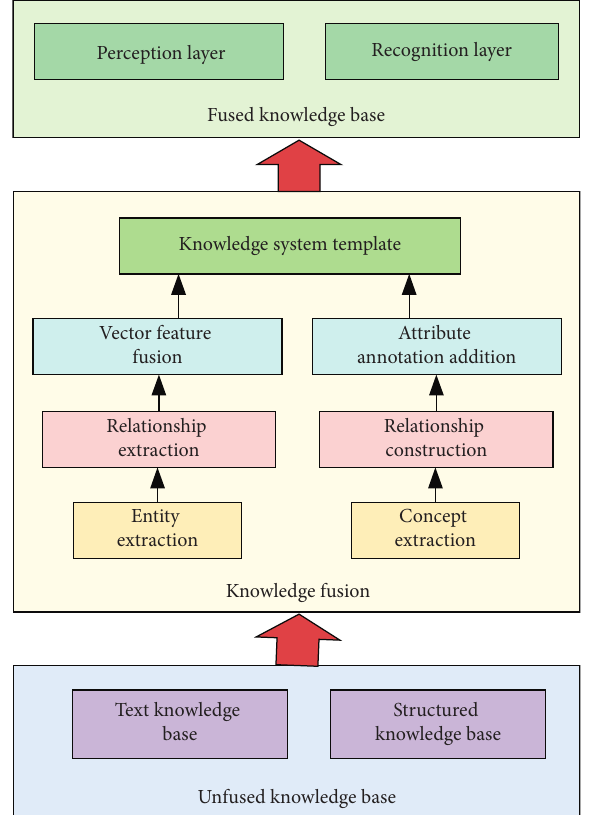
Figure 11: Flowchart of knowledge